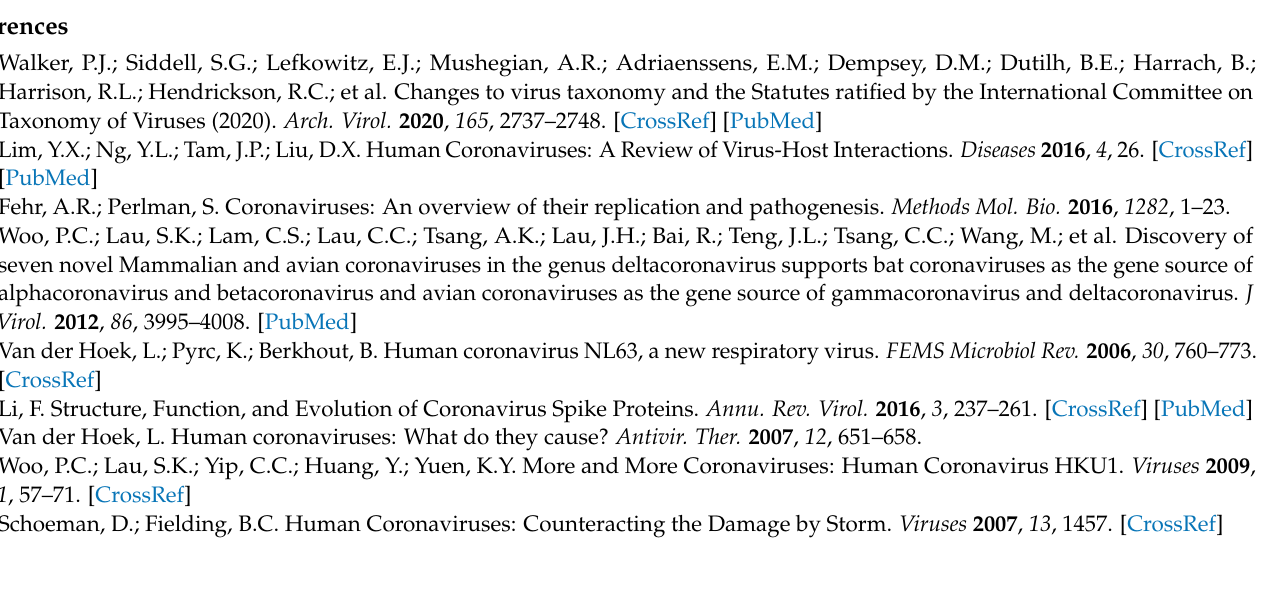
Figure S4: Phylogenetic analysis of the membrane gene sequences; Figure S5: Phylogenetic analysis of nucleocapsid gene sequences; Table S1: Predicted sizes for Eptesicus bat CoV non-structural proteins derived from polyprotein ORF1ab. *, incomplete sequence; Table S2: Predicted cleavage sites for the non-structural proteins (nsp) of Eptesicus bat